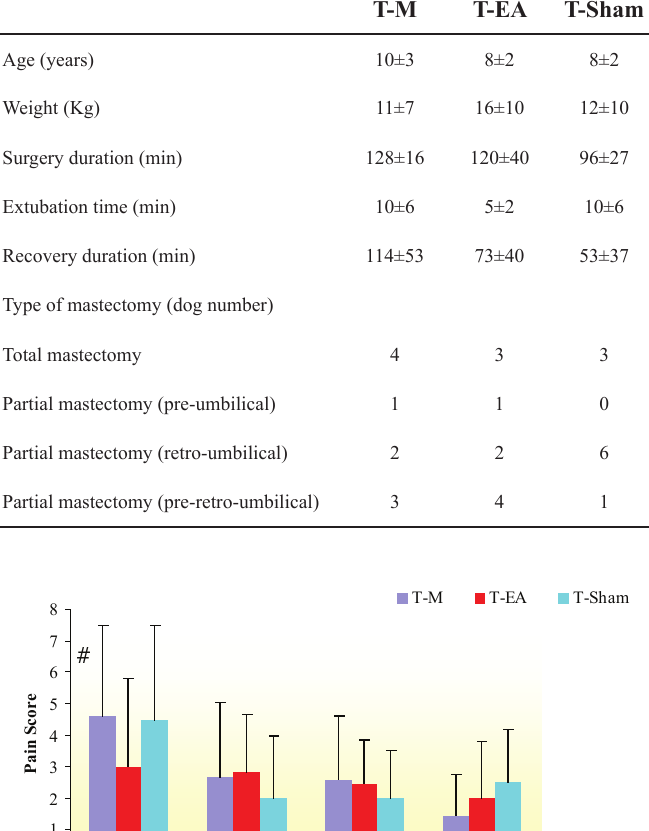
TABLE 2 - Demographic and perioperative data (mean ±SD).